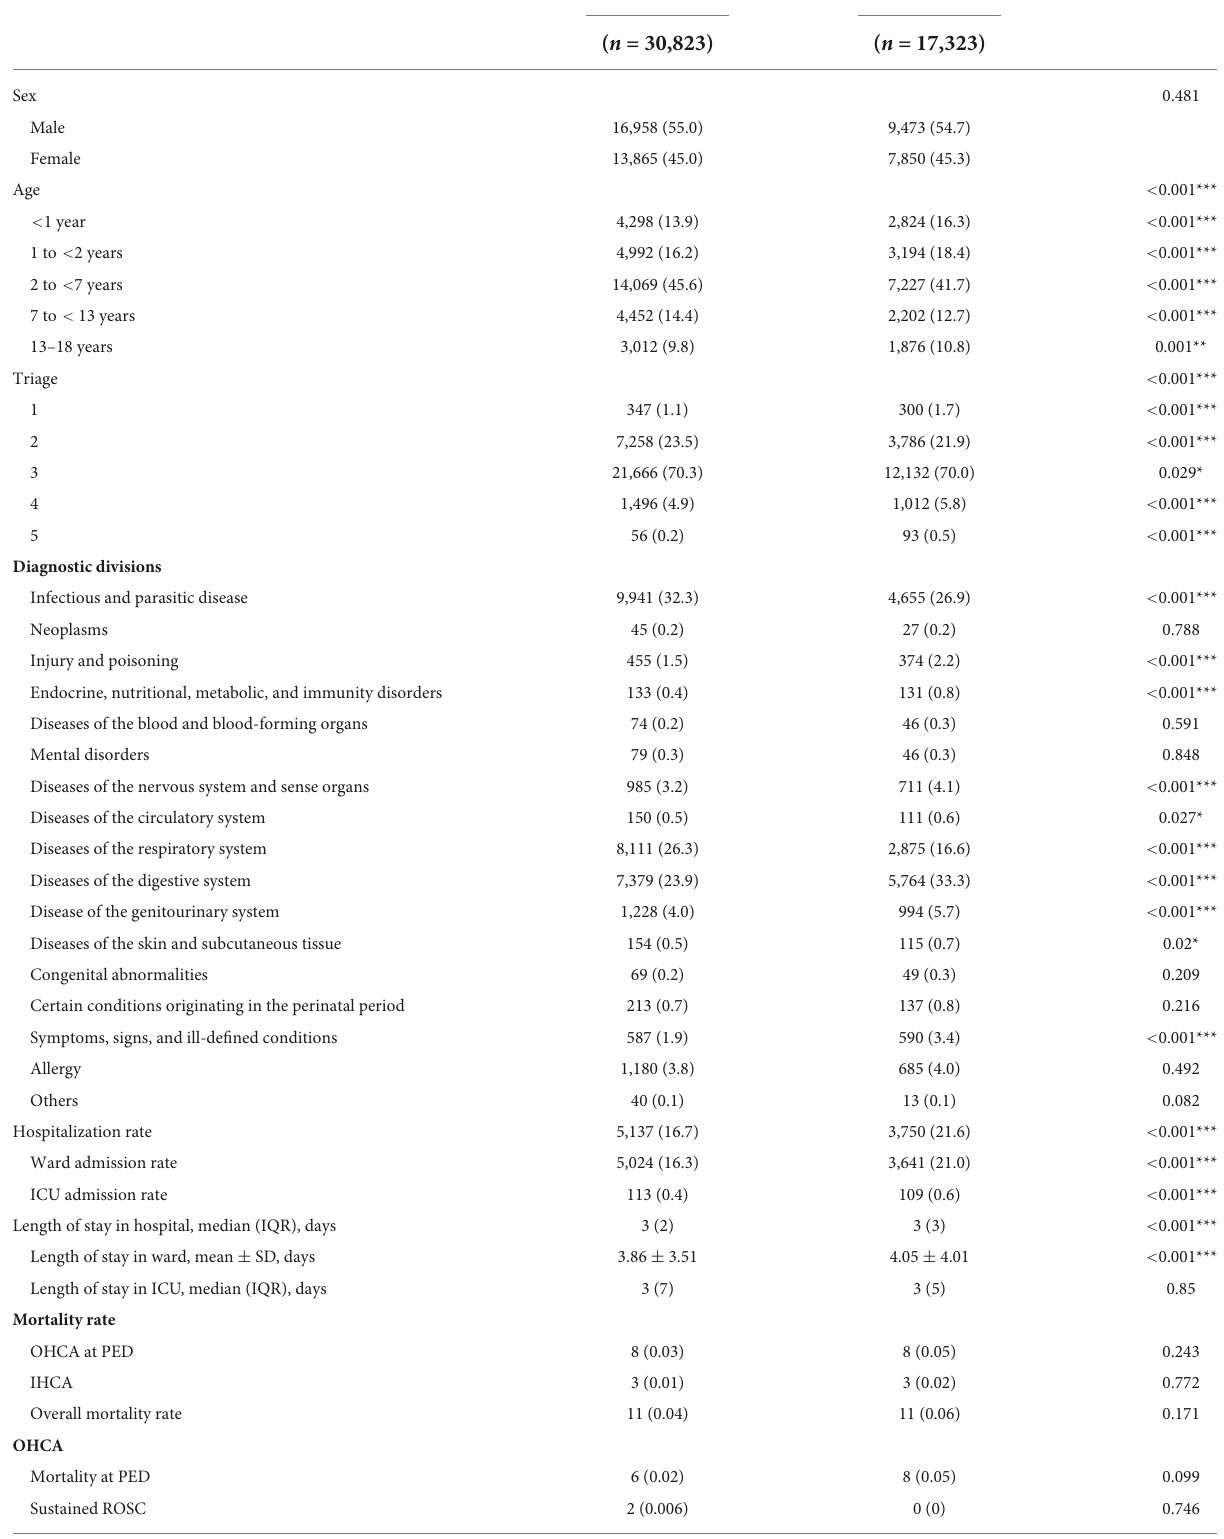
TABLE 1 Characteristics of PED patients and presentations before and after the COVID-19 pandemic [values are n